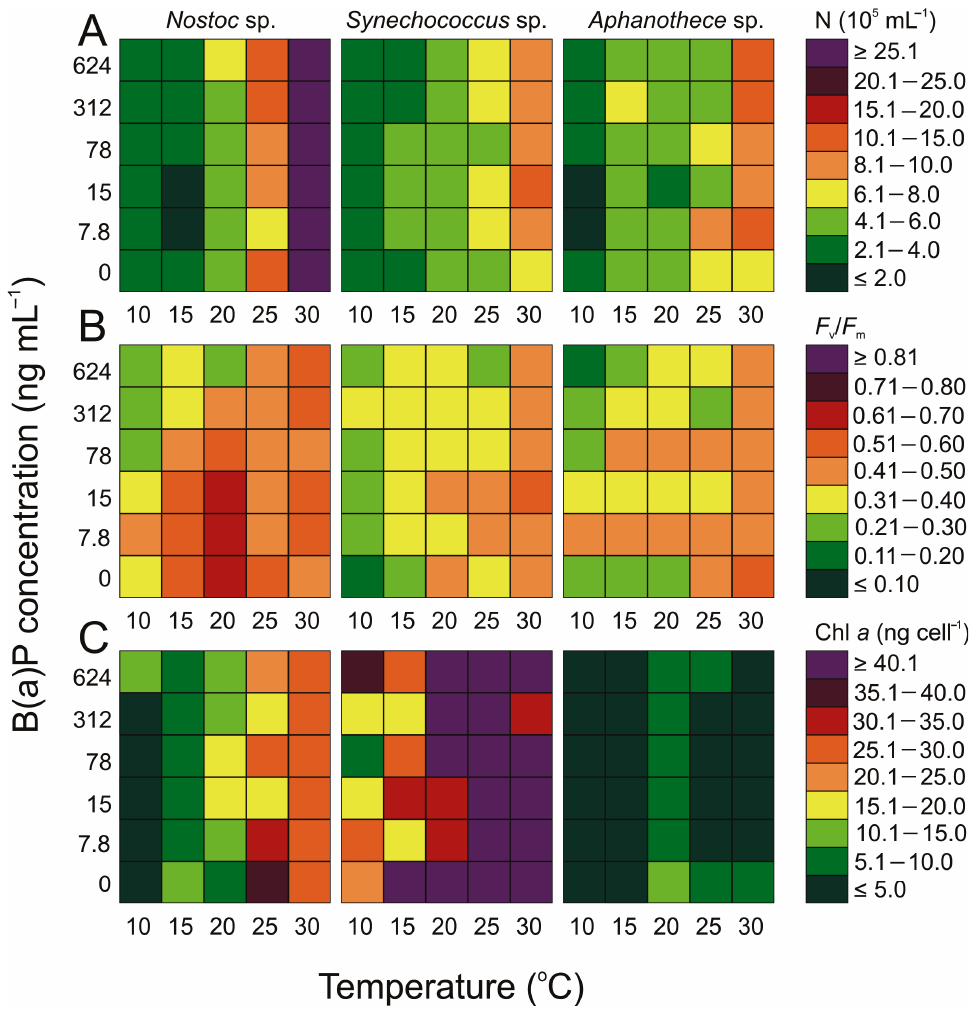
Figure 1. Changes in ( A ) the number of cells (10 5 N mL − 1 ), ( B ) maximum quantum efficiency of PSII photochemistry ( F v / F m ), and ( C ) chl a content (ng cell − 1 ) for airborne cyanobacteria obtained after 7 days of experiment under di ff erent B(a)P concentration (ng mL − 1 ) and temperature (°C) conditions. In addition to the cyanobacterium of Nostoc sp., a high number of cells was also found for the diatoms Amphora sp. (37·× 10 5 cell mL − 1 ) and Ni tz schia sp. (approximately 22·× 10 5 cell mL − 1 ), which for both of them was achieved at a temperature of 30 °C and a concentration of 15 ng mL − 1 B(a)P. On the other hand, the highest number of cells of Halam- phora sp., 11.37·× 10 5 cell mL − 1 , was observed at a B(a)P concentration of 7 ng mL − 1 and a